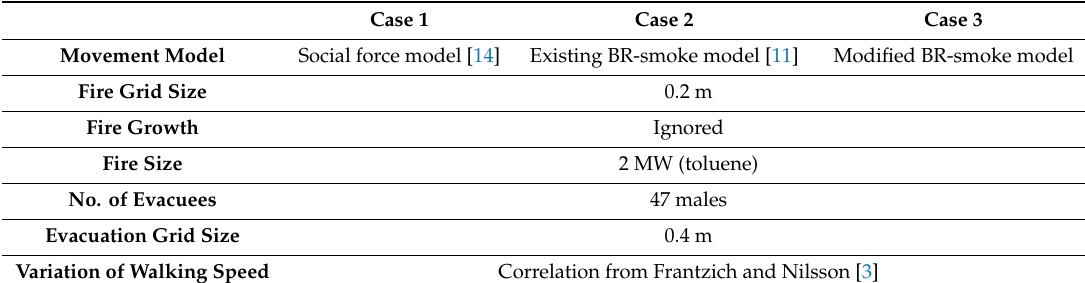
Table 1. The cases for the fire and evacuation simulations.